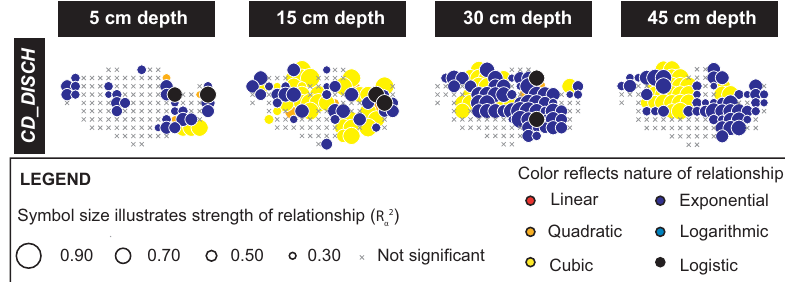
Fig. 6. Nature and strength of the relationships between point-scale soil moisture content and Q obs used as a surrogate for the Hermine catchment response. R 2 α refers to the adjusted R -square.